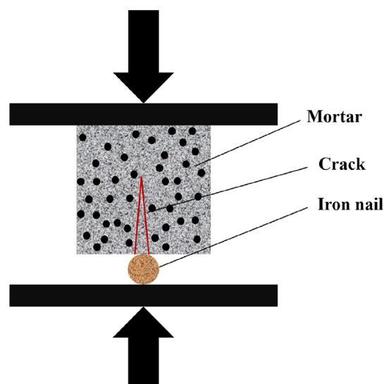
Schematic diagram of mortar pre-cracking by splitting test.